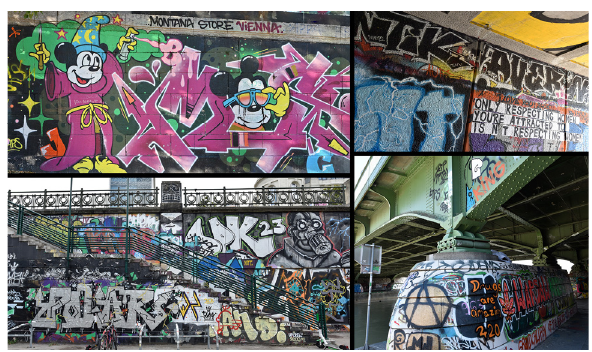
Figure 1 . The large variation in graffiti at the